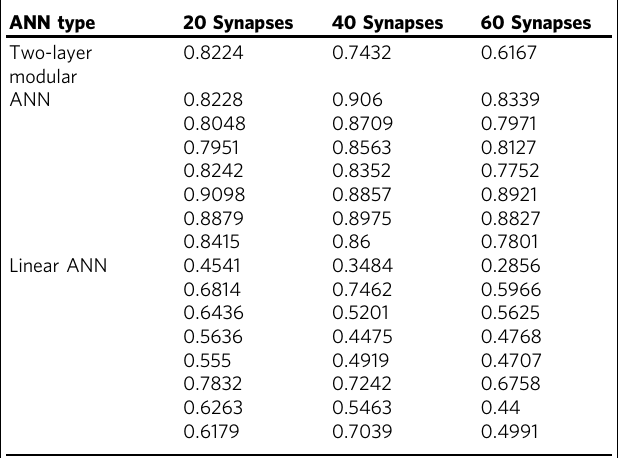
Table 1 ANN regression performance ( R 2 ) for individual sets of synapses in the eight model